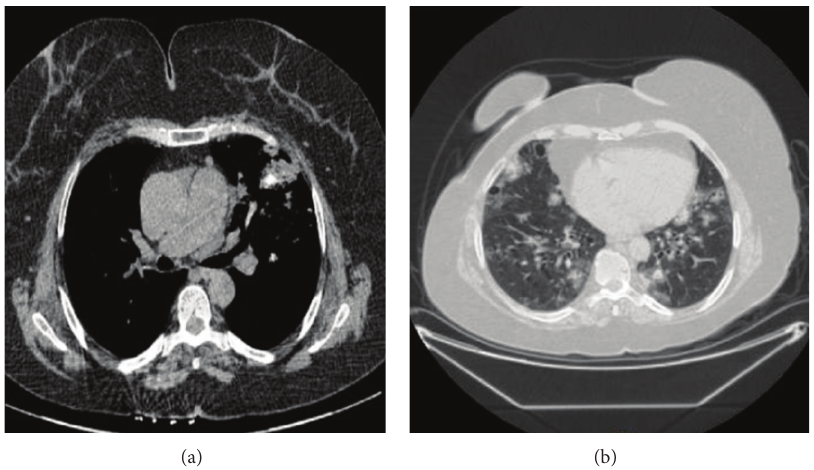
Figure 1: Multiple calcified nodules, air cysts in both lungs, and lymphadenopathy in the mediastinum on chest tomography.